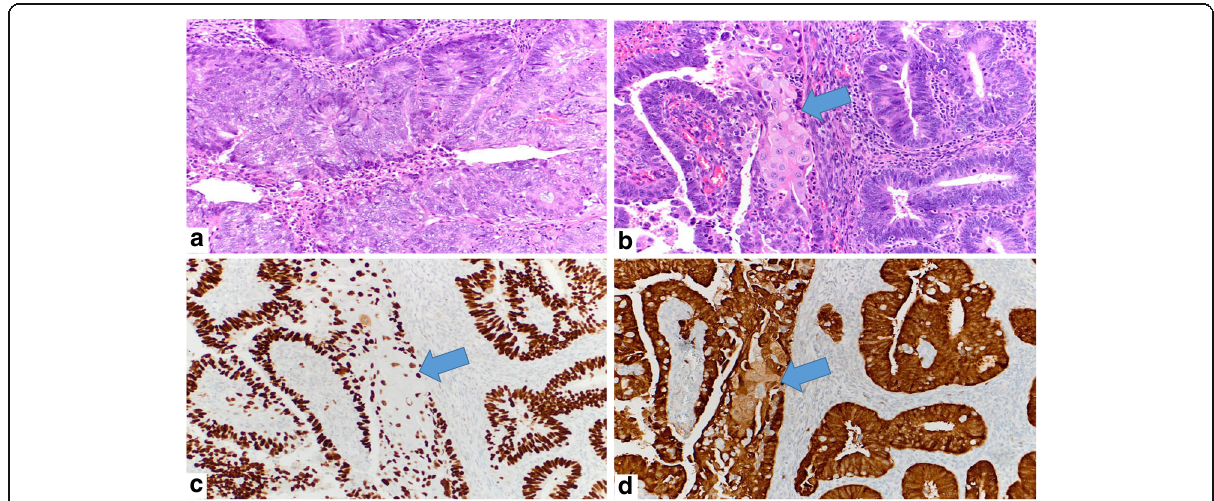
Fig. 3 Morphologic and immunophenotypic features of the p53-aberrant areas of tumor at its primary site (arrows indicate focus of squamous differentiation, consistent with an endometrioid histotype). a , b Morphologic features, showing increased atypia and mitotic activity in a p53- aberrant area of the tumor, compared to the p53-wild type areas as illustrated in Fig. 1b [H and E, original magnification: 40 x]. c p53-aberrant immunophenotype. [original magnifications: ×40]. d , 1H: p16-diffusely positive immunophenotype. [original magnifications: